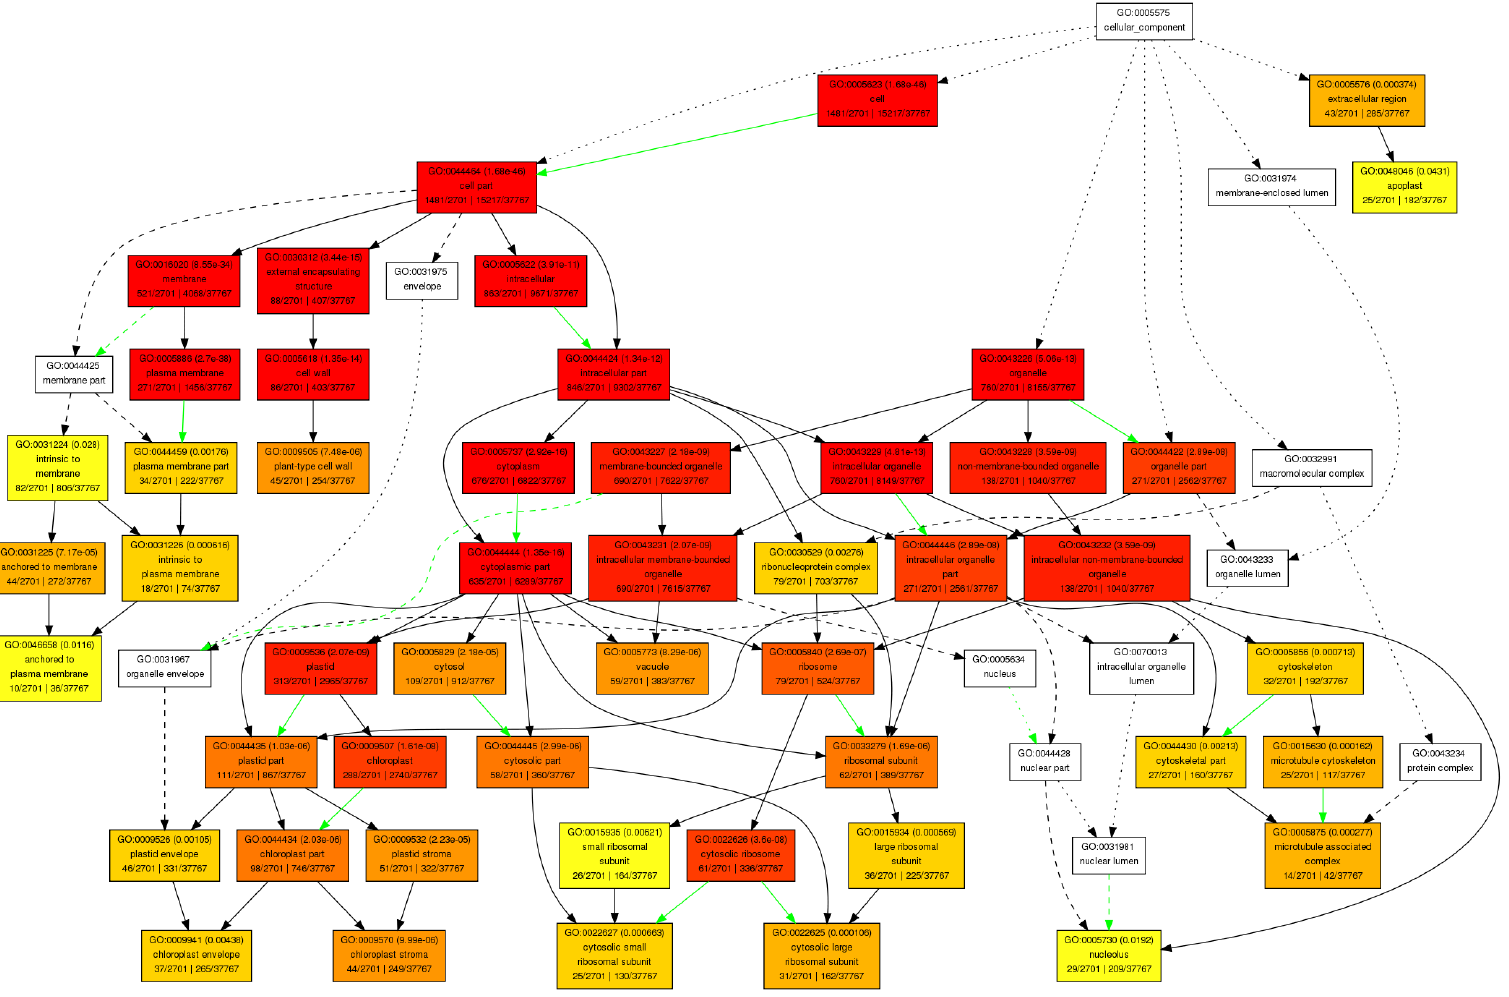
Figure A2. Cellular component pathway.